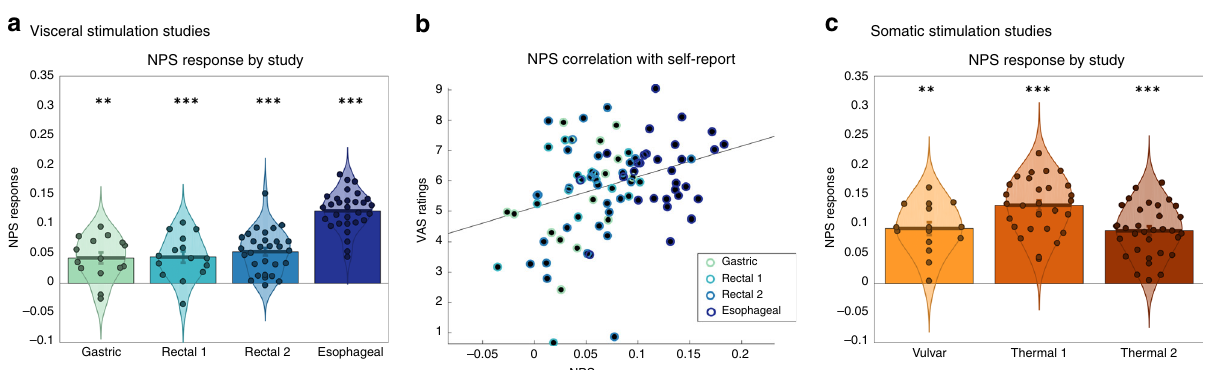
Fig. 1 Response of the neurologic pain signature (NPS) to different types of aversive/painful stimulation. a NPS response to visceral stimulation types. Units re fl ect the cosine similarity of activation images and the NPS (see “ Methods ” for details). Each circle indicates the NPS response for an individual subject ( N s = 15, 15, 29, and 30). Bar plots (mean ± standard error) and violin plots of NPS responses for each visceral study. b Scatterplot of the relationship between the average NPS response and average visual analog scale (VAS) ratings of experienced pain (after accounting for the effect of study). c NPS response to somatic stimulation types ( N s = 15, 28, and 33) units re fl ect cosine similarity. Bar plots (mean ± standard error) and violin plots of NPS responses for each somatic study. ** P < 0.01, *** q FDR < 0.05 (two-tailed, one-sample t test). Source data are provided as a Source Data